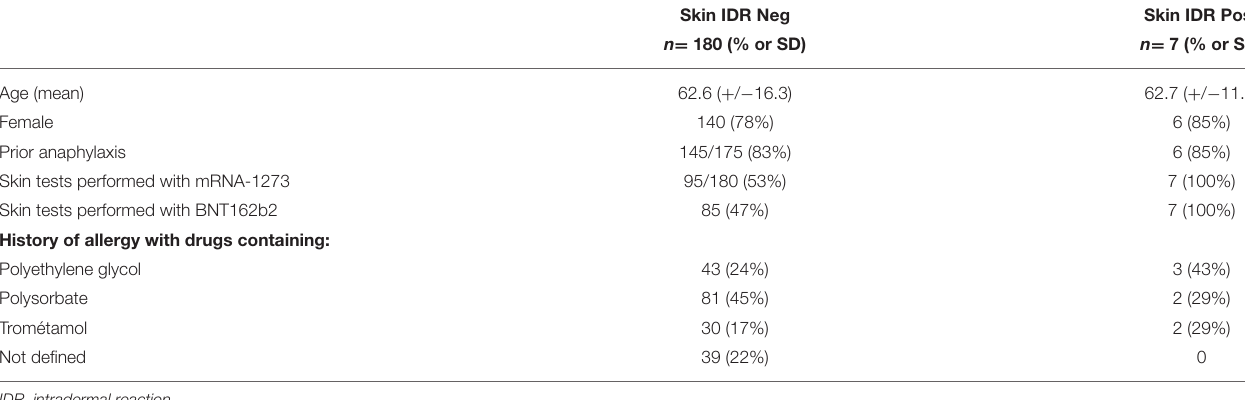
TABLE 2 | Characteristics of patients with positive and negative skin tests in the pre-vaccination cohort.